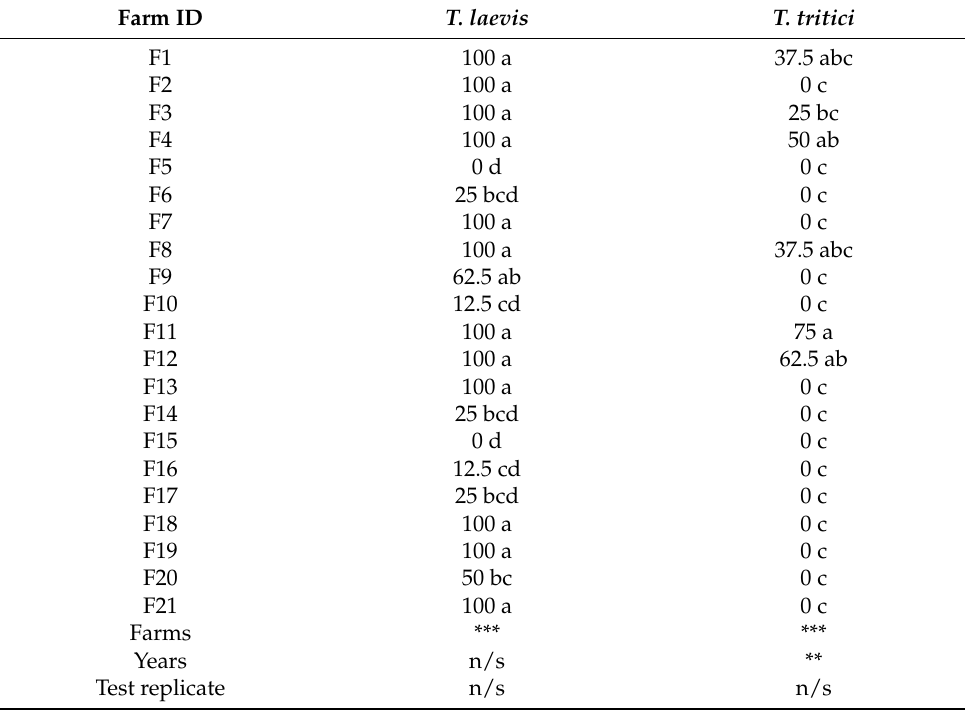
Table 2. Presence of Tilletia spp. (as frequency of infection) on each farm surveyed over the two study years.